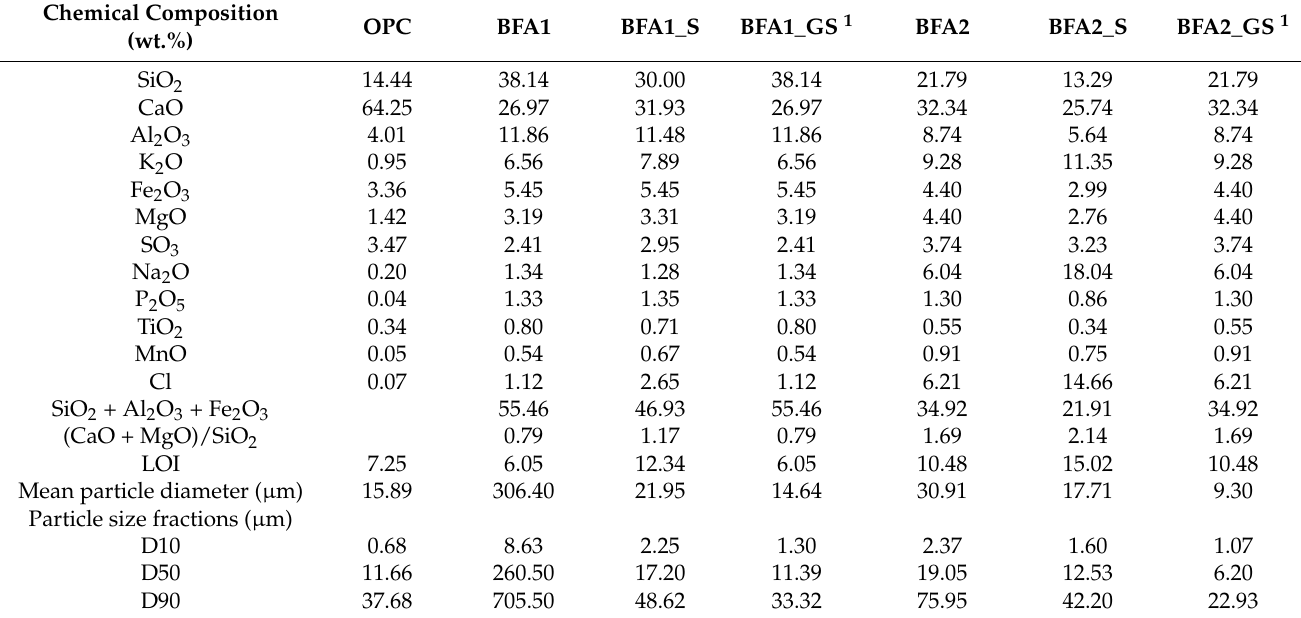
Table 2. Chemical composition, LOI, and particle size of OPC and BFA